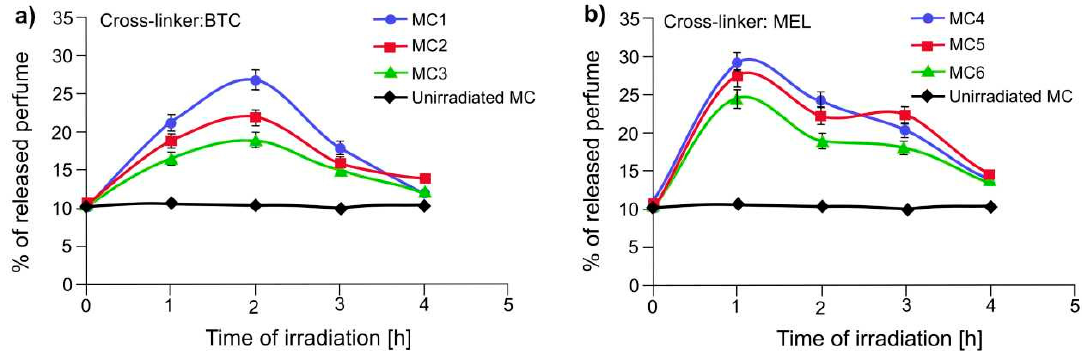
Figure 9. Percentage of released perfume from the polyamide microcapsules prepared with 1,3,5- benzenetricarbonyl trichloride ( a ) and melamine ( b ).